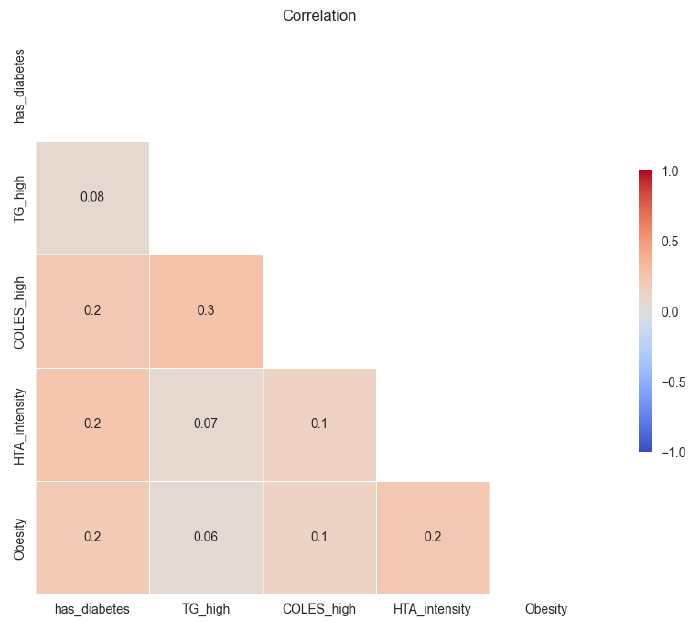
Figure 3. Correlation of comorbidities variables.